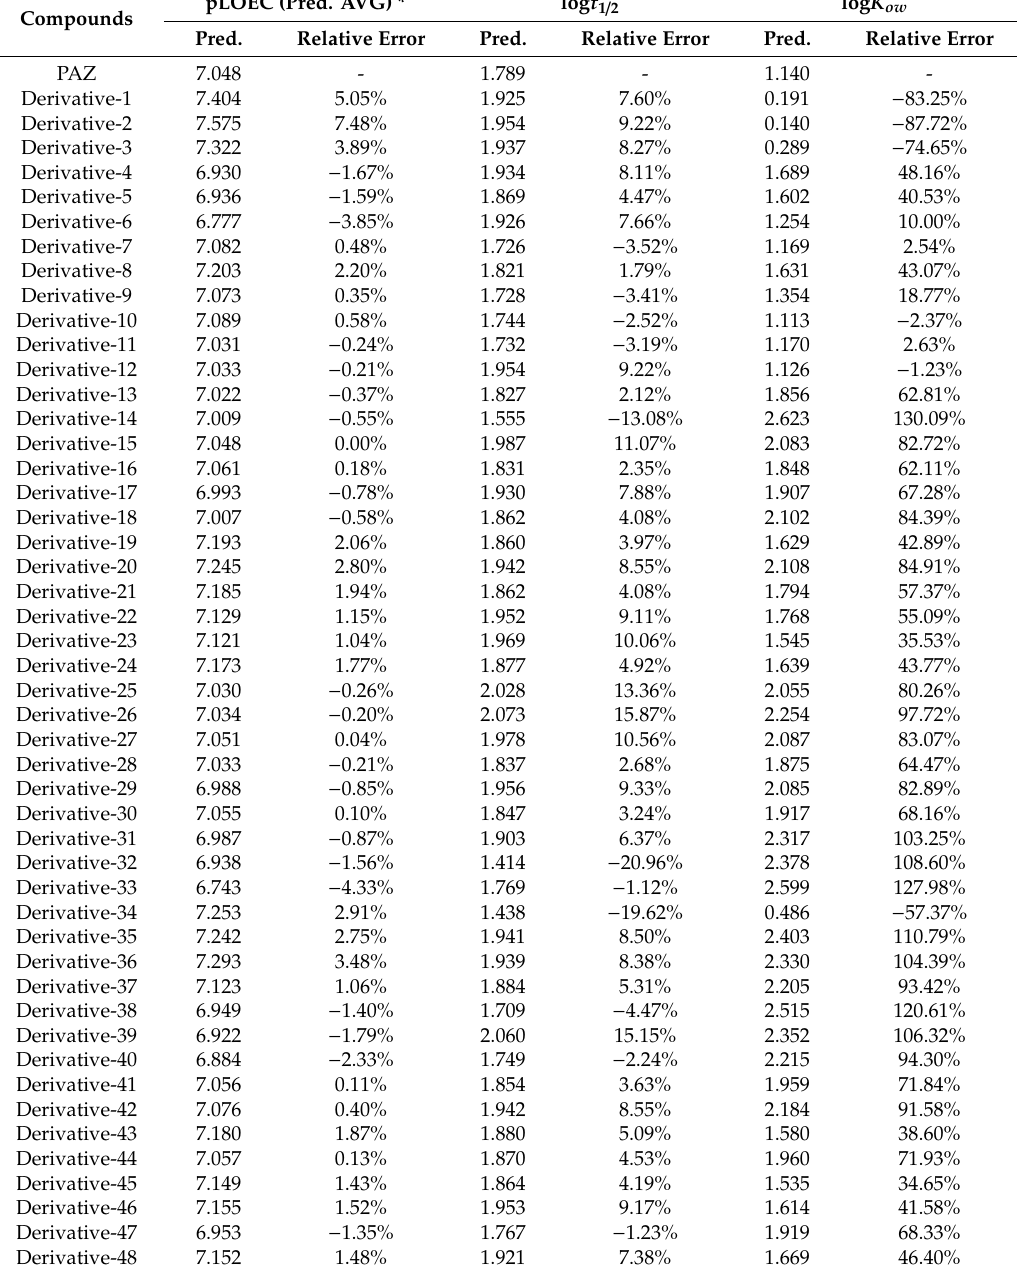
Table 5. Evaluation of POPs characteristics of PAZ derivatives based on constructed